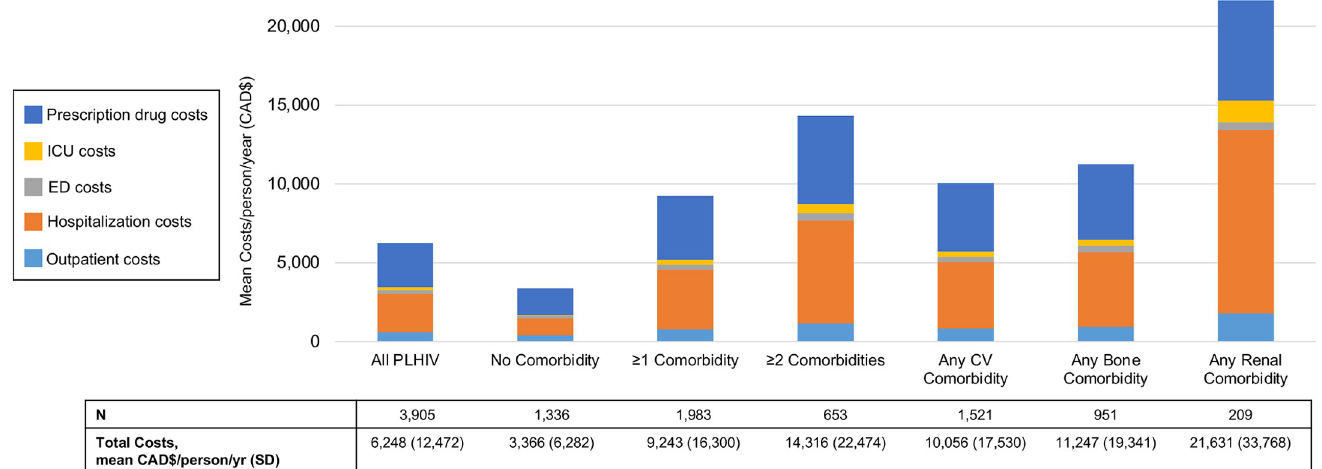
Fig 3. Mean total healthcare costs of PLHIV without CV, bone or renal comorbidity and PLHIV in different comorbidity categories. Mean healthcare costs per patient per year are shown for all patients, as well as those with at least one comorbidity, any CV comorbidity, any bone comorbidity, any renal comorbidity, and no CV, bone or renal comorbidities. Comorbidity categories are not mutually exclusive since one patient could have more than one type of comorbidity.